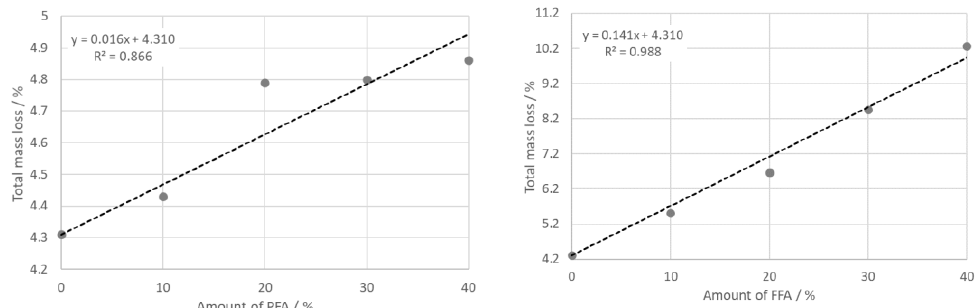
Figure 3. The total mass loss of PF ( left ) and FF ( right ) samples (determined at 900 °C).